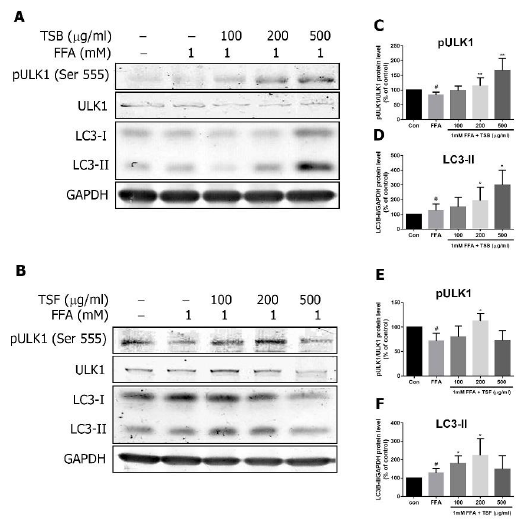
Figure 10. Effects of TSB and TSF on the LC3 pathway in FFA-treated HepG2 cells. ( A and B ) Immunoblots of phosphorylated ULK and LC3 subunits. ( C – F ) The bar graphs show densitometric data (mean ± SD) from three to five independent experiments. # P < 0.05 compared with the control group (con). * P < 0.05 and ** P < 0.01 compared with the FFA group. J. Clin. Med. 2019 , 8 , x FOR PEER REVIEW 3.9. Inhibitory Effects of Compounds from T. sinensis on Lipid Accumulation in FFA-Treated HepG2 Cells To determine which of T. sinensis ’ active components regulate lipid metabolism, cells were pre- treated with gallic acid, quercetin, rutin, methyl gallate, ethyl gallate, kaempferol, or toosendanin prior to FFA treatment. Lipid accumulation was measured 24 h after FFA exposure by Nile red staining. The effective levels of compounds were nontoxic to all cells (data not shown). We found that gallic acid, rutin, and quercetin at a level of 50 g/mL significantly reduced FFA-induced lipid contents (Figure 11A – C), whereas ethyl gallate, methyl gallate, and tannic acid at nontoxic levels had no effects (data not shown). Additionally, toosendanin at levels of 0.05, 0.1, and 0.5 M significantly reduced FFA-induced lipogenesis (Figure 11D).